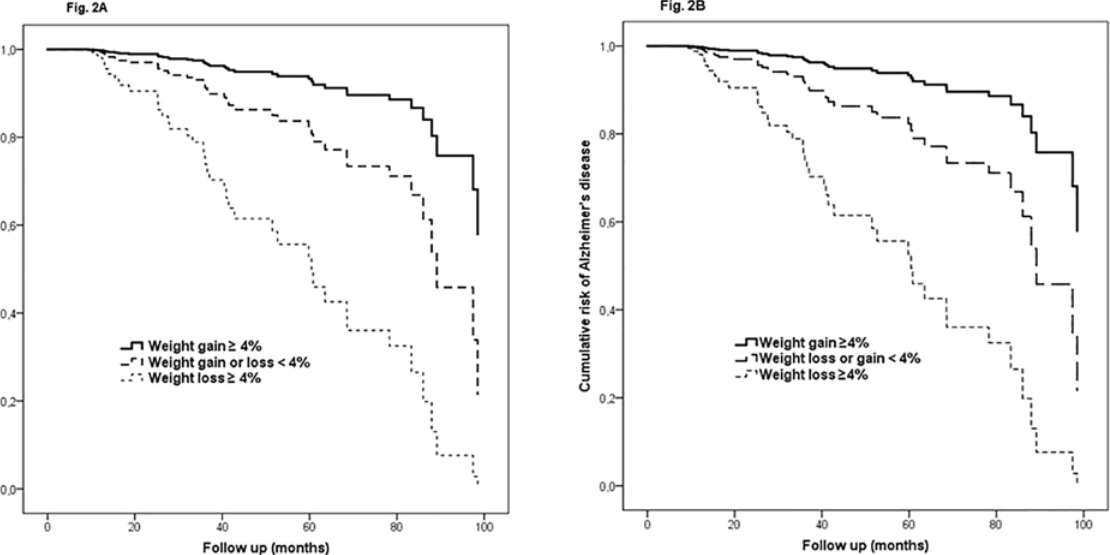
Fig 2. Cumulative risk curves of the effects of body weight change on progression from mild cognitive impairment (MCI) to dementia (A) and Alzheimer ’ s disease (B). The figure derived from a model adjusted for sex, age, education, Mini-Mental State Examination score, MCI subtypes, APOE genotype, smoking habit, depression, diabetes, cerebrovascular disease, ARWMC score, comorbidity total